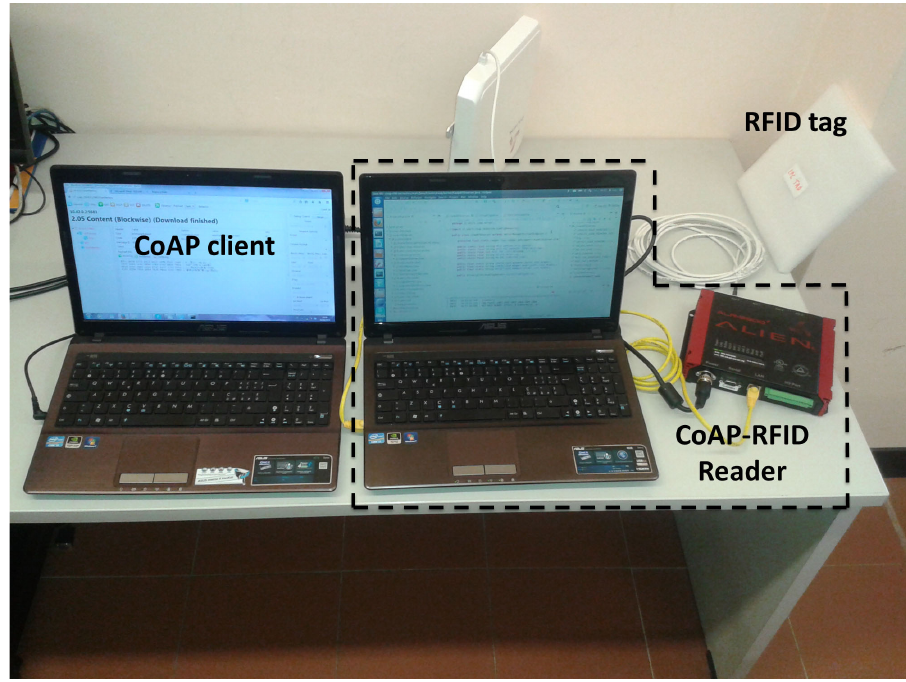
Figure 6. Testbed